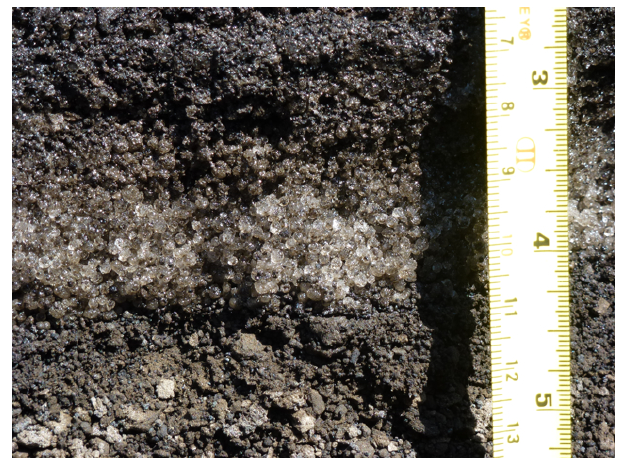
Figure 11. Photograph of a vertical section taken on the Vatna- jökull glacier at a location where there was significant ash fall from Grímsvötn, on 31 May 2011. There is evidence of millimetre-sized hail in the deposit. Photo taken by Adam Durant during a visit or- ganized by Fred